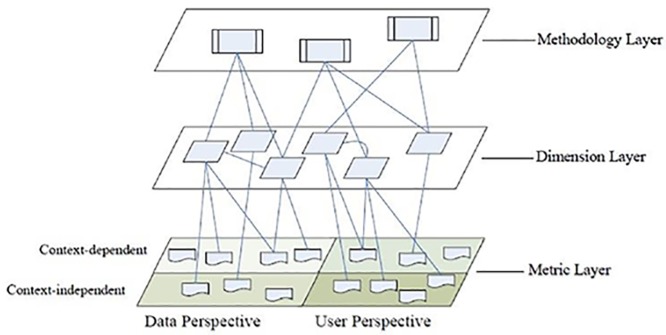
A Framework of DQ Assessment[6].